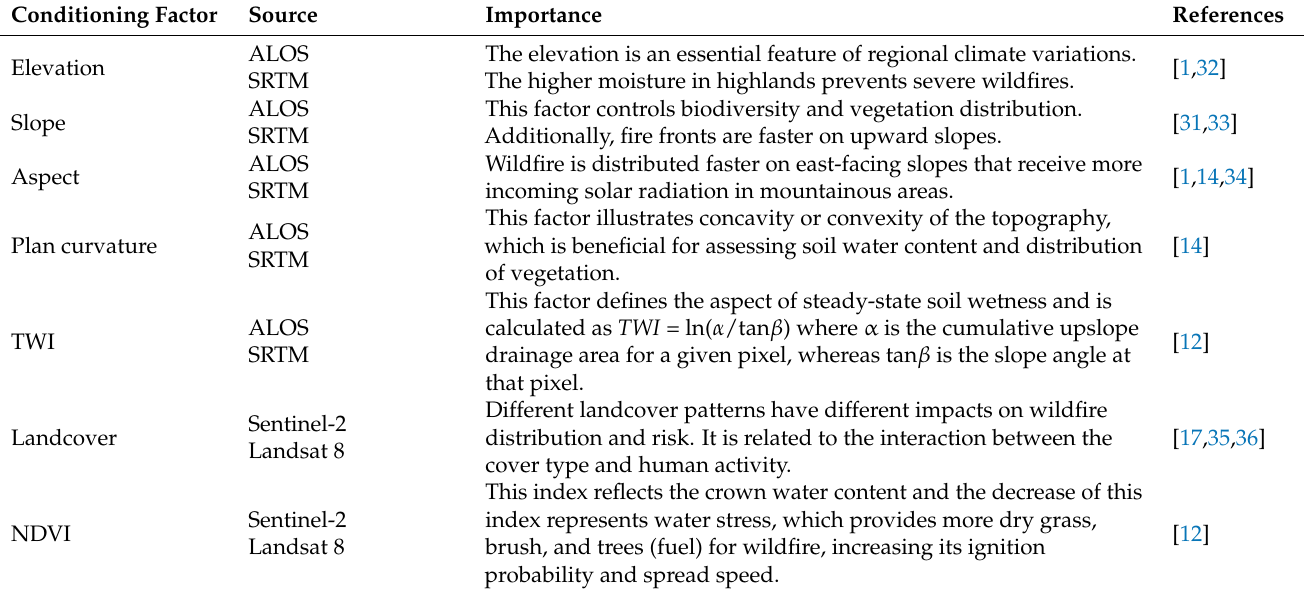
Figure 6. The conditional factors considered in both datasets overlaid with the wildfire inventory points. The pixel size was resized based on the corresponding dataset. ( a ) Mean wind power density (MWPD), ( b ) mean wind speed (MWS), ( c ) precipitation, ( d ) temperature, ( e ) village density, ( f ) distance to rivers, ( g ) distance to roads, and ( h ) wildfire inventory. Table 2. A summary of the literature review: significance of the selected conditioning factors for wildfire susceptibility prediction